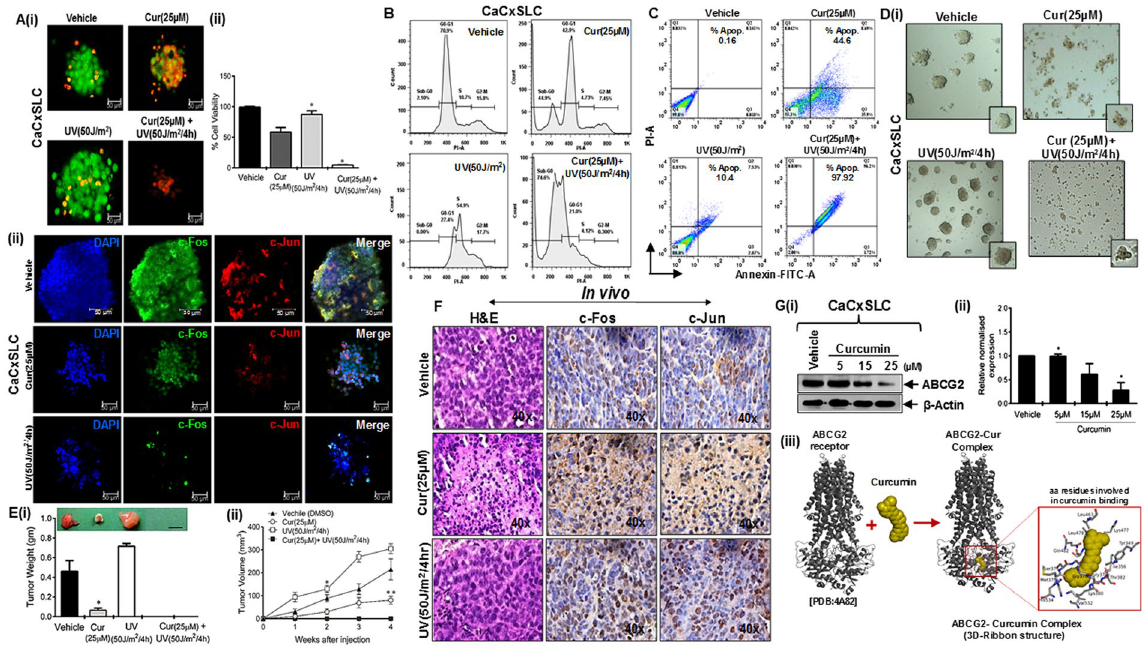
Figure 6. Combinatorial interaction of curcumin and UV-radiation on cell proliferation and survival. ( A ) Effect of curcumin and UV-irradiation on cell proliferation. Representative immunofluorescence image of day10 cervicospheres derived from CaCxSLCs treated with curcumin(24 hr) or UV-irradiation(4 hr) or in-combination by acridine orange/ethidium bromide (AO/EtBr) staining as described in Methods. Scale bar = 50 μ m. ( B ) Effect of curcumin and UV-irradiation on cell cycle. Representative histogram showing cell cycle distribution as assessed by propidium iodide (PI) staining. ( C ) Flowcytometric analysis of day10 cervicospheres derived from CaCxSLCs treated as mentioned above and analyzed using AnnexinV- FITC apoptosis detection kit as per manufacturer’s instructions described in Methods. ( D ) Assessment of cervicosphere forming ability. Representative photomicrograph of day10 cervicospheres derived from treated CaCxSLCs under low adherence environment in DCM (original magnification-100x) (i). Representative confocal immunofluorescence image of day10 CaCxSLC cultures treated with curcumin(24 hr) and/or UV- radiation(4 hr). Each cultures were fixed and stained with primary (c-Fos and c-Jun) and (Alexa-488 or Alexa- 594 conjugated goat anti-mouse or anti-rabbit) secondary antibodies and counterstained with DAPI. Merged photograph indicate co-localization of AP-1 in nuclei. ( E ) Tumor weight derived from post-treated CaCxSLCs (20 × 10 3 ) measured after 4-weeks post-injection in the athymic nude mice (i). Data presented as mean ± SE, * p value < 0.05 w.r.t. vehicle treated tumor. Tumor growth curves of post-treated CaCxSLCs (20 × 10 3 each) at 4-weeks post-injection in the athymic nude mice (ii). Data presented as the mean ± SE, * p value < 0.05 w.r.t. vehicle treated tumor. ( F ) H&E staining and IHC of tumors derived from curcumin or UV treated CaCxSLCs (original magnification-400x). ( G ) Representative cropped blots showing expression level of ABCG2 in extracts prepared from CaCxSLCs treated with different doses of curcumin(24 hr). β -actin was used as input control (i). The gels were run under the same experimental conditions. The abundance ratio of ABCG2 to β -actin was analyzed by densitometry. Data are expressed as the mean ± SD of three independent experiments (ii). * p-value < 0.05 vs. vehicle treated cells from CaCxSLC-derived cervicospheres. (iii). Representative 3D-ribbon structure of ABCG2(grey) and curcumin(yellow) complex. Red square showing binding area of curcumin in ABCG2 receptor. Close-up view showing ABCG2 amino-acid residues involved with curcumin